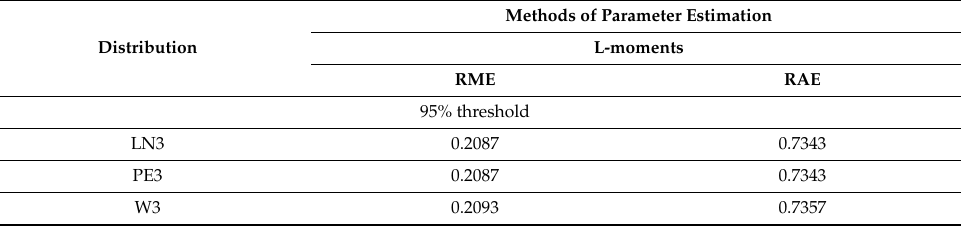
Table 14. Distribution performance values for annual drought